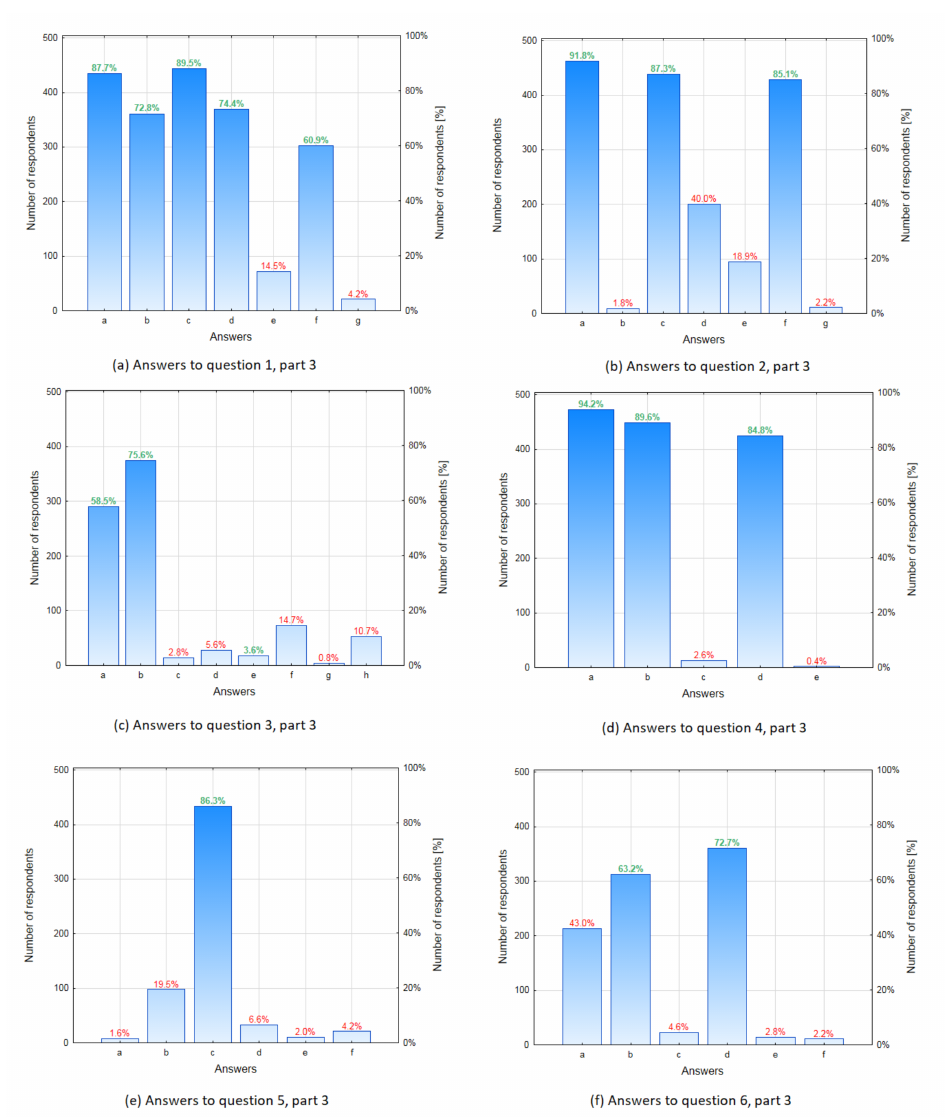
Figure A1. ( a – f ) Answers to first questions 1–6 from part 3 of the survey. The most recommended answers are marked green, and other answers are marked